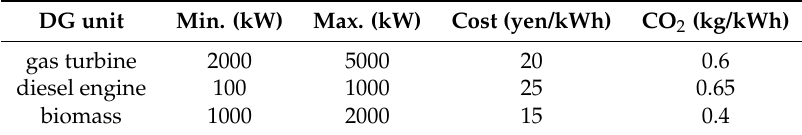
Table 4. Summary of distributed generation characteristics including minimum and maximum generation capacity, cost per kWh, and carbon